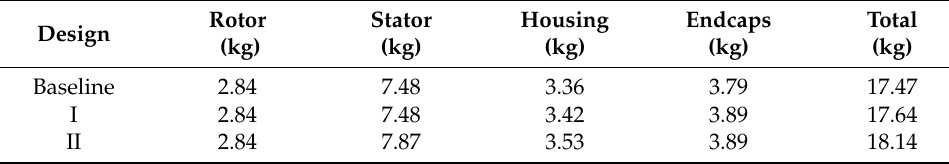
Figure 26. Acoustic noise comparison for Designs I and II. Table 14. Designs I and II mass